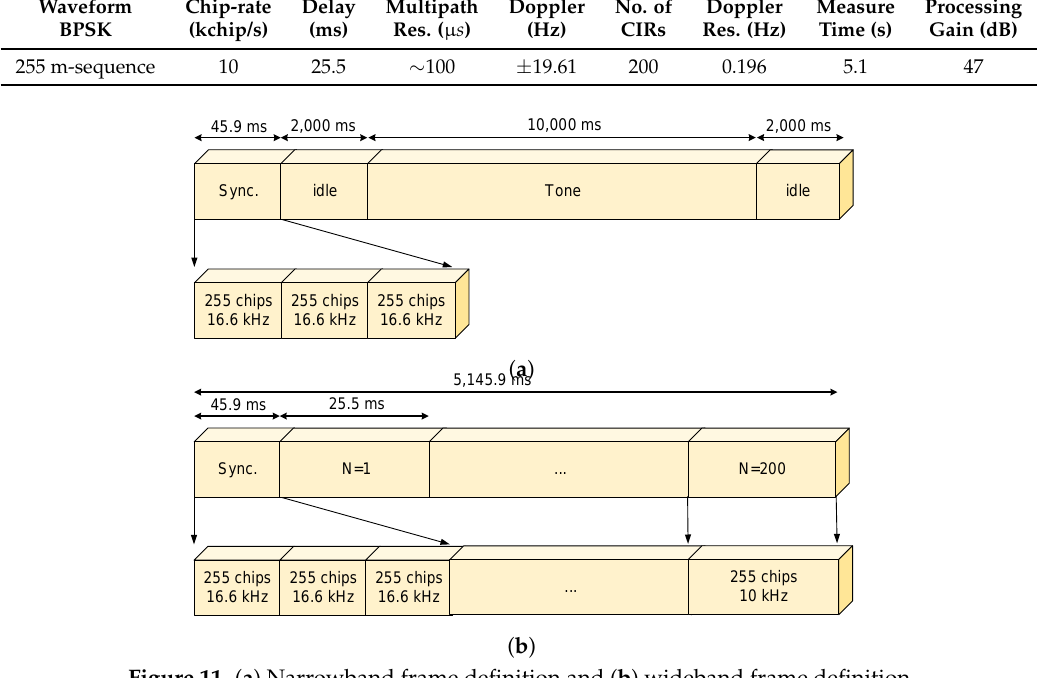
Figure 11. ( a ) Narrowband frame definition and ( b ) wideband frame definition.